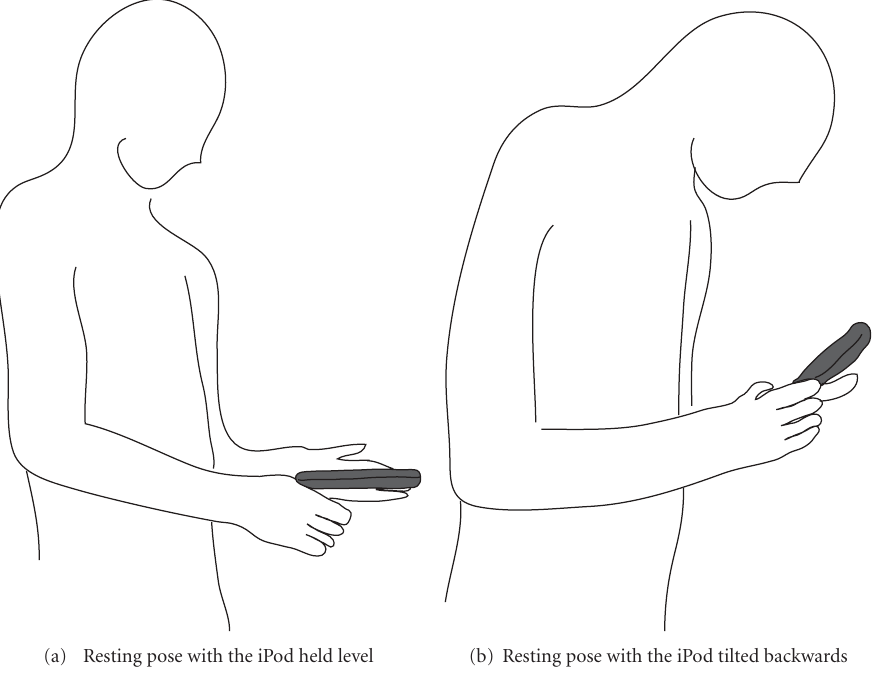
Figure 14: Resting poses observed while participants used the